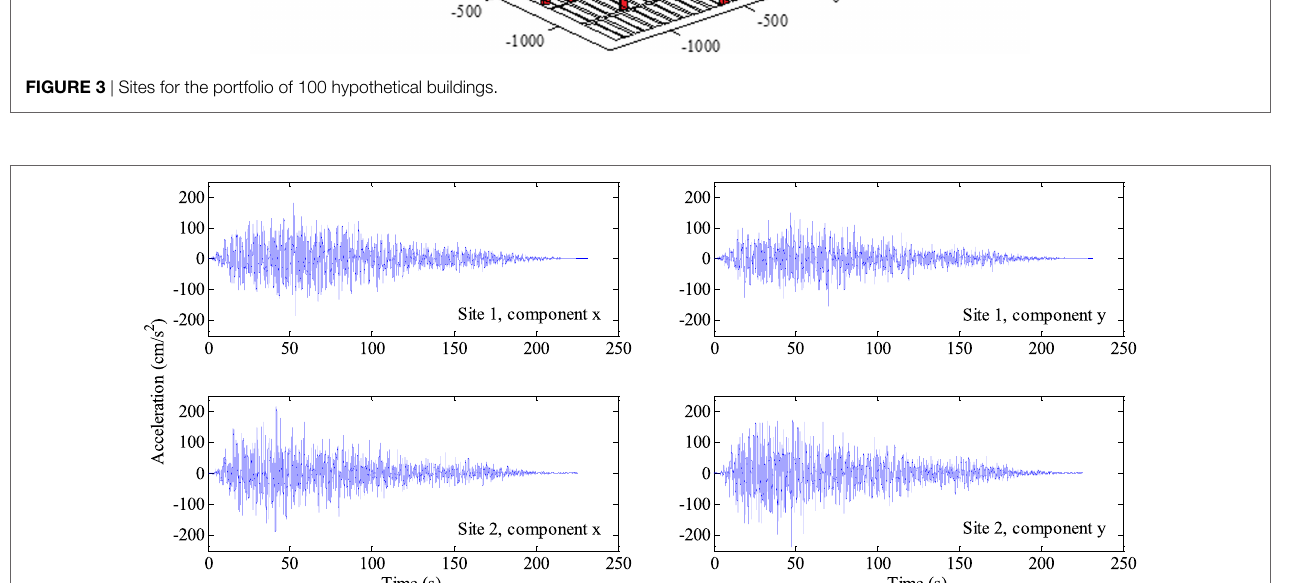
FIGURE 4 | Illustration of simulated spatially correlated and coherent records for two selected sites.